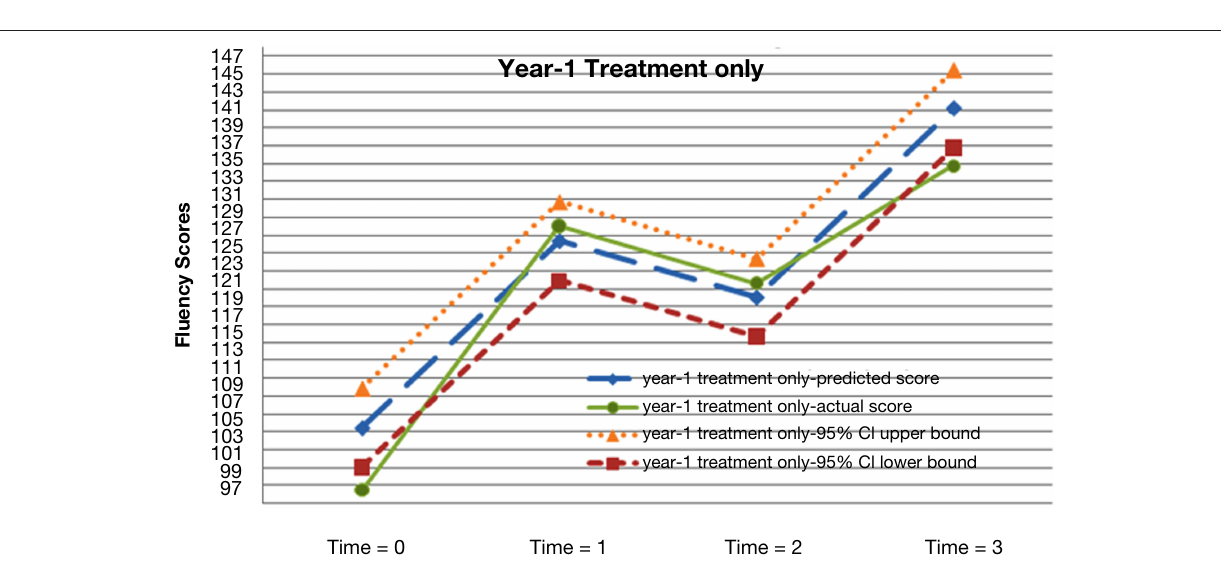
Figure 3 | Actual and predicted growth trajectories for students who received the treatment during year-1 as well as 95% confidence intervals around the predicted growth